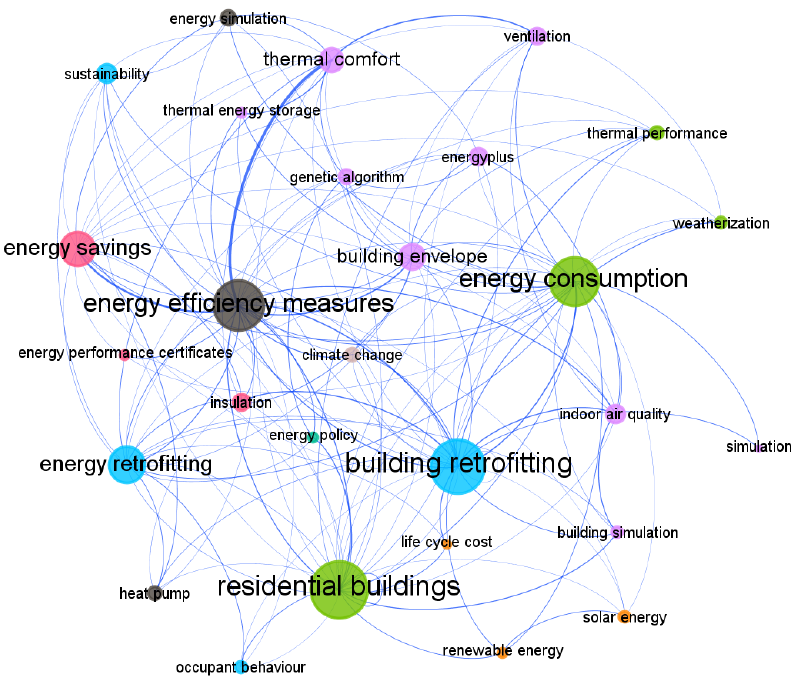
Figure 4. Main research areas in retrofitting residential buildings.